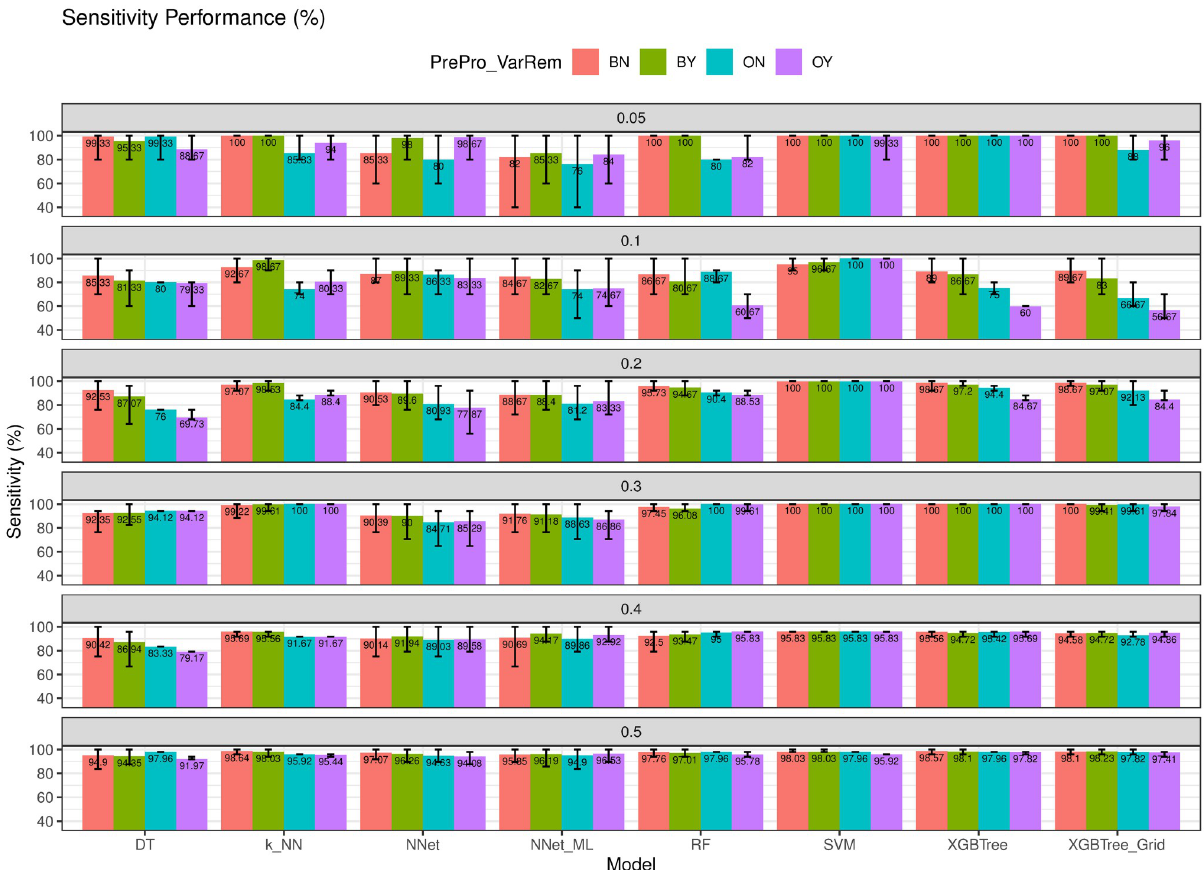
Fig 17. Sensitivity with different ratios of minority to majority classes. Models trained with ENUS improved the performance by 4.69%.